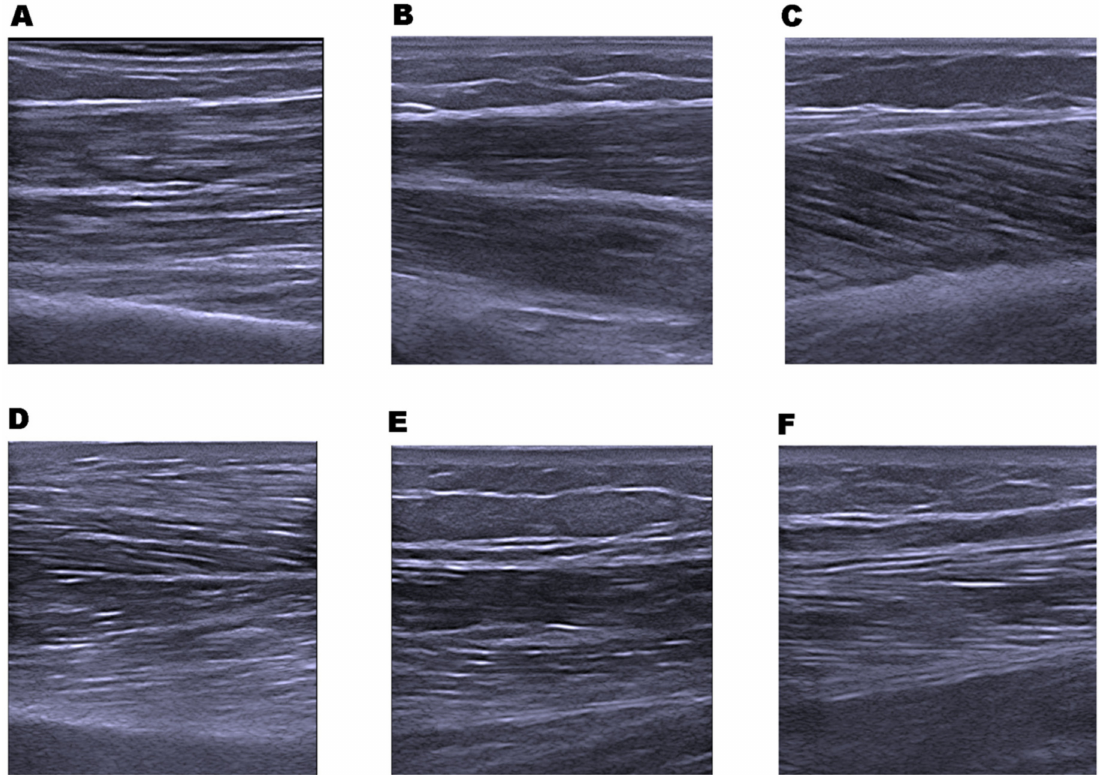
Figure 1. Example of muscle ultrasound images. ( A ) Biceps brachii; ( B ) wrist flexors; ( C ) medial gastrocnemius; ( D ) tibialis anterior; ( E ) rectus femoris; and ( F ) rectus